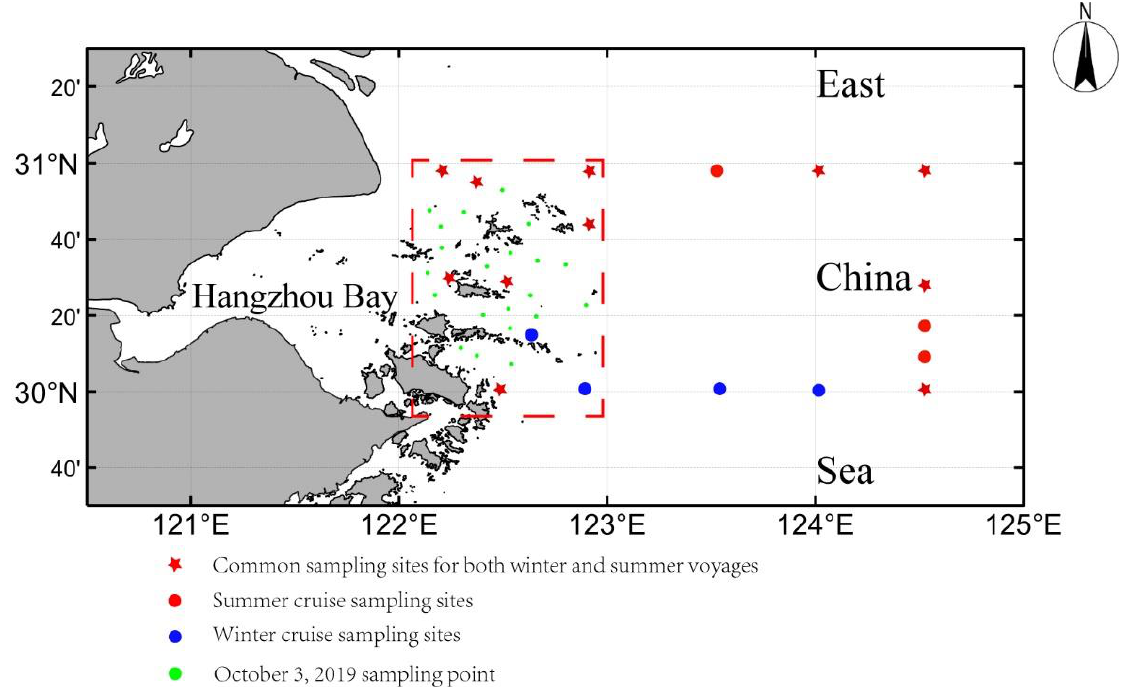
Figure 2. Distribution of sampling sites. The red square: the distribution of sampling points for the data used in this paper.